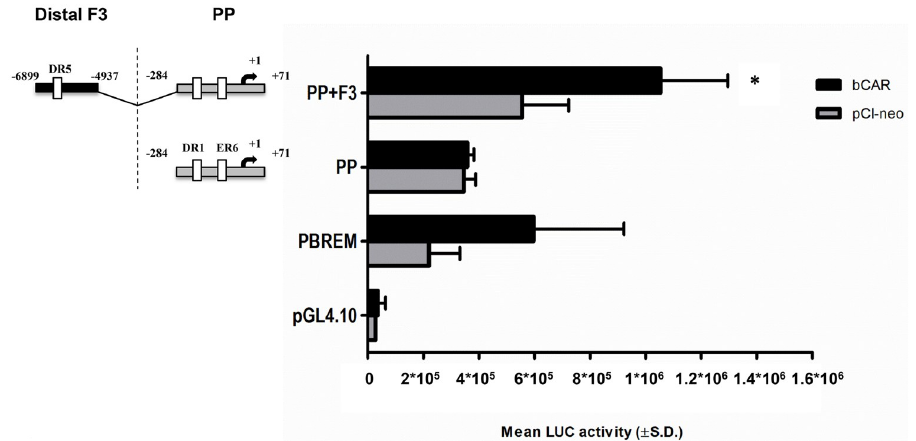
Fig 6. bCAR-mediated transactivation of the proximal promoter and the fragment 3 in CYP3A28 promoter. The transactivation by bCAR of the most responsive fragments PP and F3 was evaluated. C3A cells were transfected with the control reporter pCMV β (150 ng/well), each reporter plasmids or PBREM-tk-luc (PBREM, 50 ng/well) and either bCAR expression plasmids or pCI-neo empty vector (25 ng/well). After transfection, cells were treated with vehicle (0.1% DMSO) for 24 hours, and reporter activities were measured. Firefly luciferase activities were normalized with β - galactosidase activities. Data are expressed as mean luciferase activities ± SD (n = 3 or 4). Results shown are representative of 3 independent assays. Statistical significance P < 0.05: � , PP-F3 with empty pCI-neo vs . bCAR.